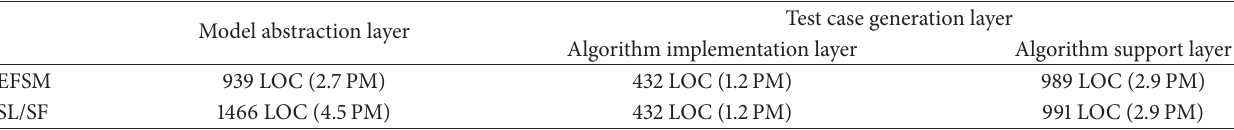
Table 1: Source code sizes of efforts of each model (using genetic